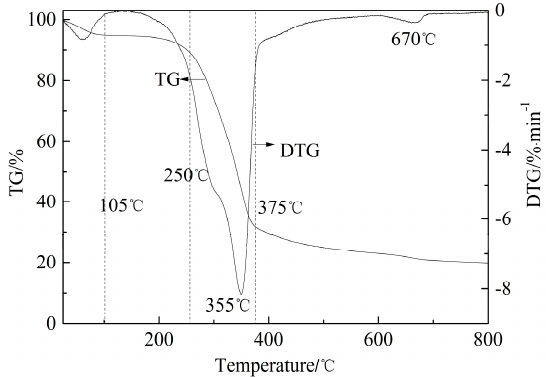
Figure 5. TG/DTA curves of sawdust pyrolysis. Figure 5. TG / DTA curves of sawdust